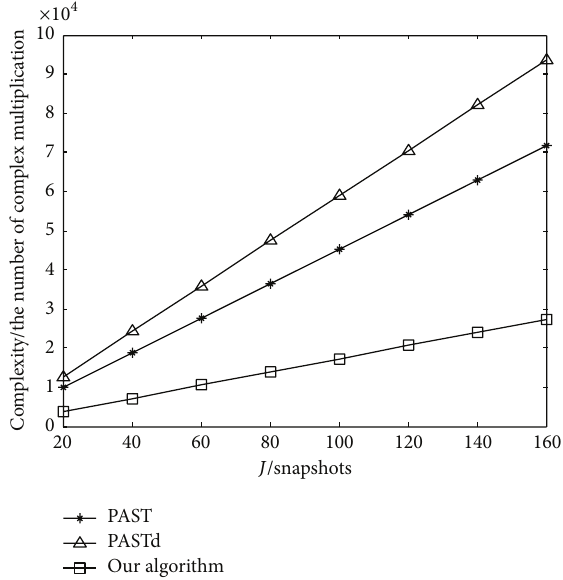
Figure 2: Complexity comparison with 𝑀 = 8 , 𝑁 = 6 , 𝐾 = 3 , and different 𝐽